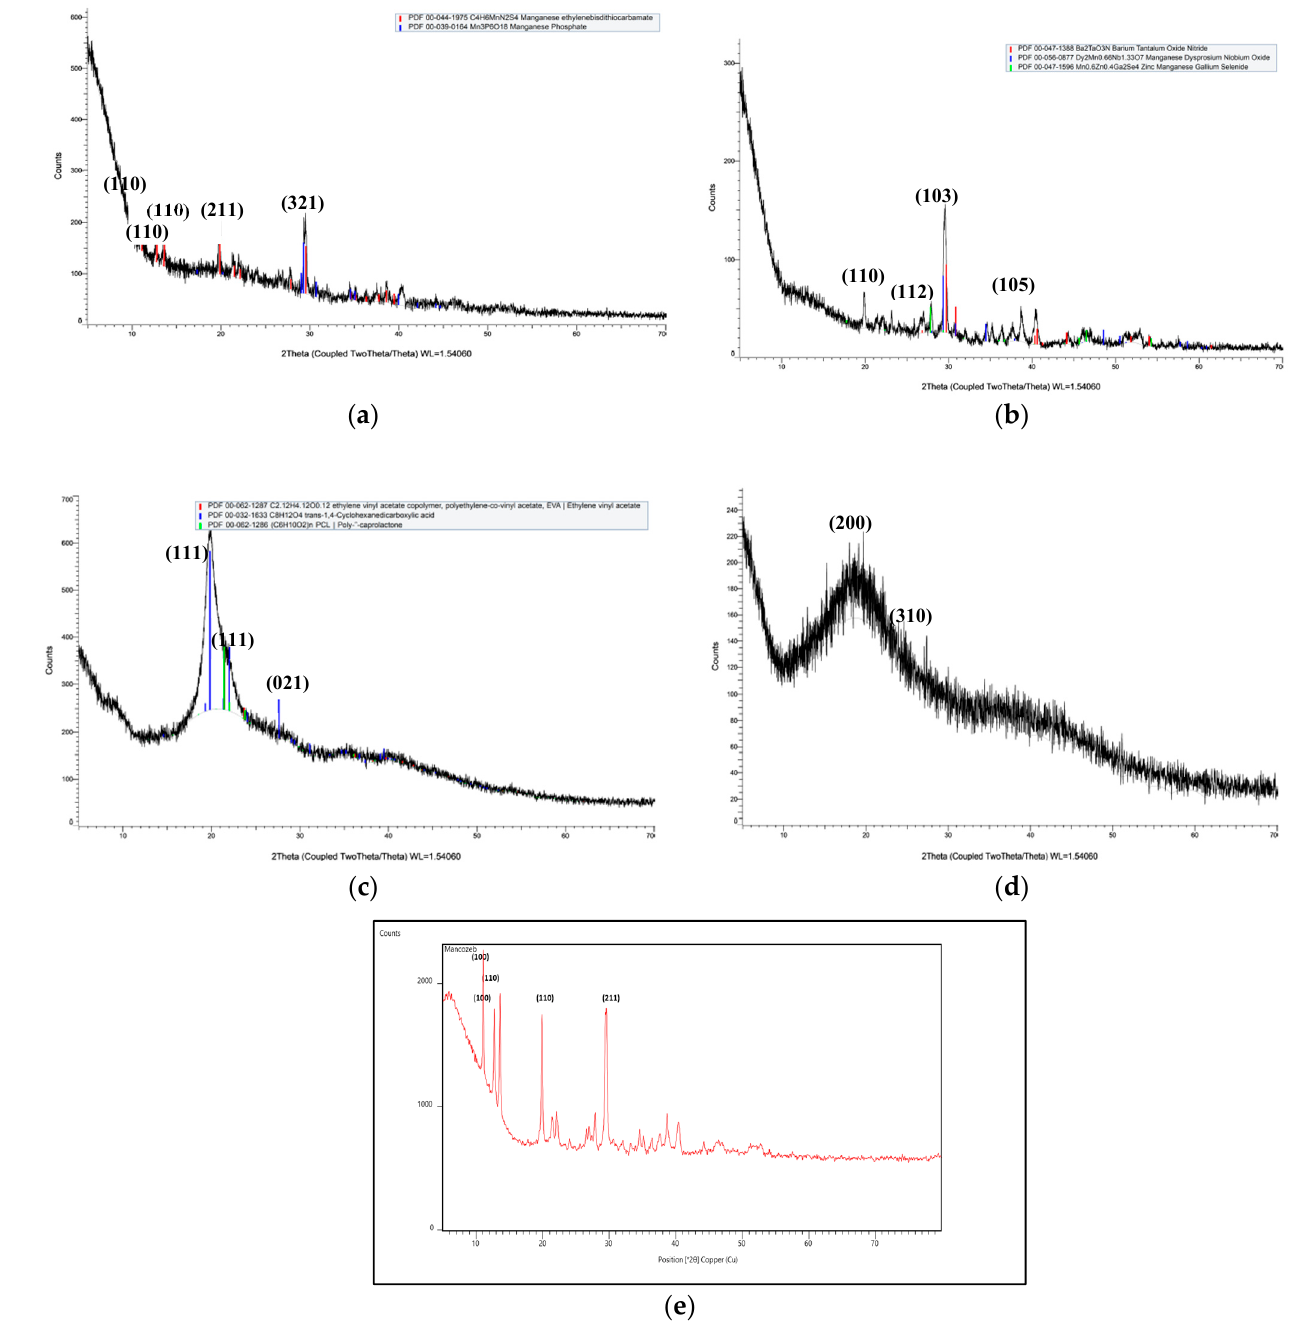
Figure 5. XRD peaks of blank and mancozeb loaded nanoformulations: ( a ) chitosan–gum acacia blank nanocomposites; ( b ) mancozeb loaded chitosan–gum acacia nanocomposites; ( c ) chitosan biopolymer; ( d ) gum acacia biopolymer; ( e ) mancozeb.